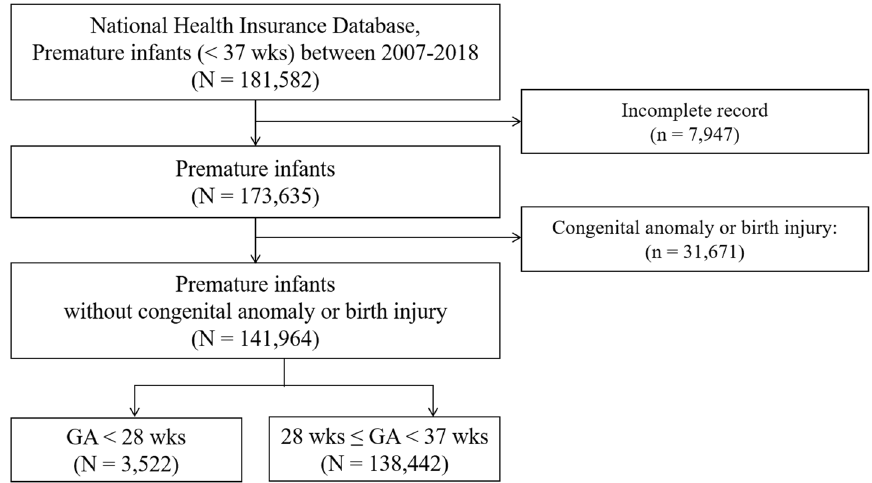
Figure 1. Flow chart illustrating the process of creating the cohort. Premature infants with a gestational age (GA) < 37 weeks who were born between 2007 and 2018 were enrolled. GA gestational age, ROP retinopathy of